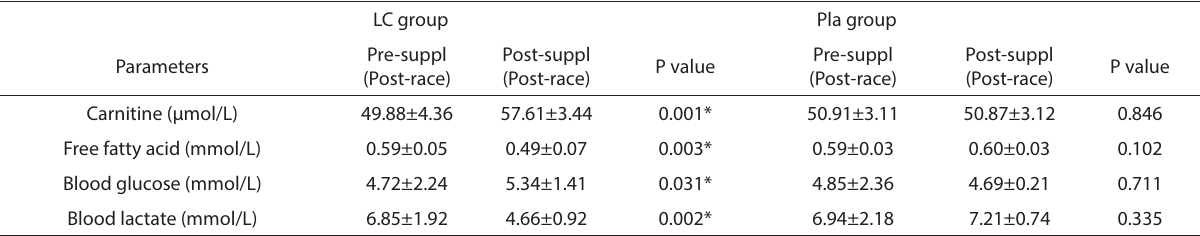
Table 4. Physiological responses to the race within a group before and after supplementation